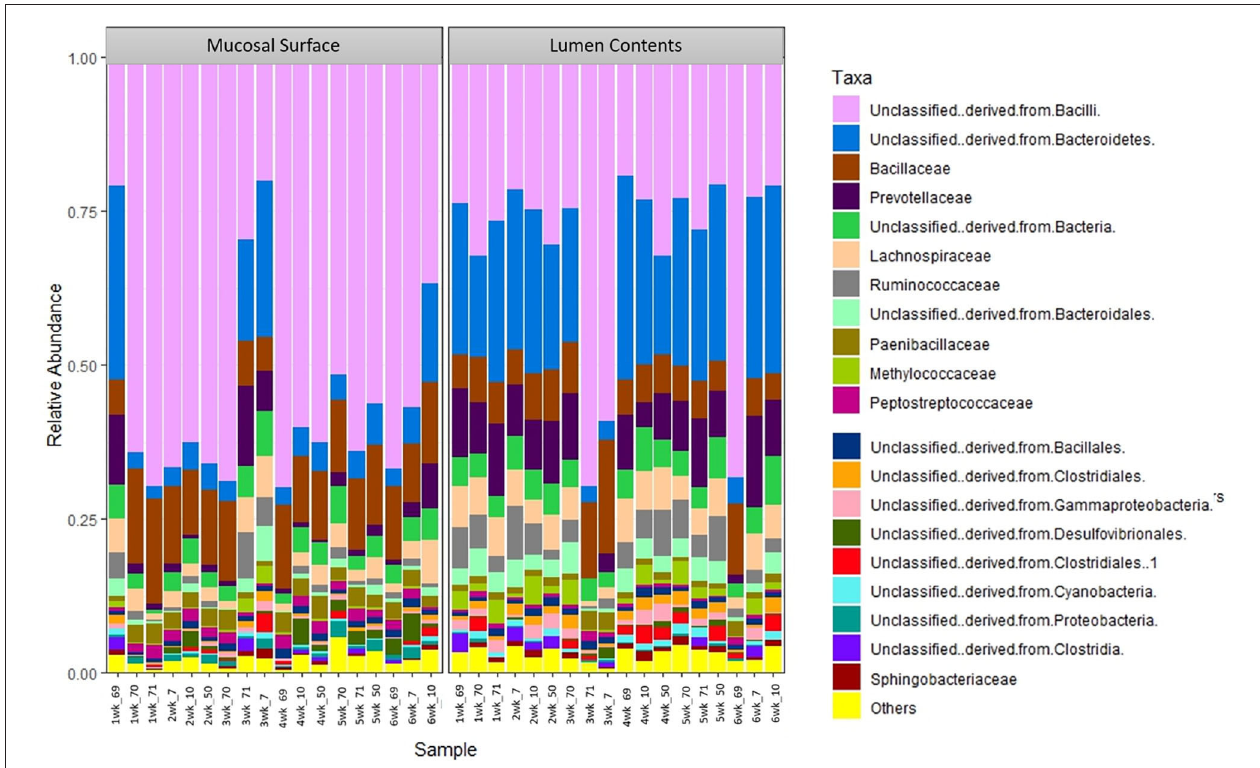
FIGURE 6 | Bacterial family. Stacked bar chart representing the abundance of the microbiota at the family taxonomic level in the mucosal biopsy surface and lumen contents across the sampled weeks for each